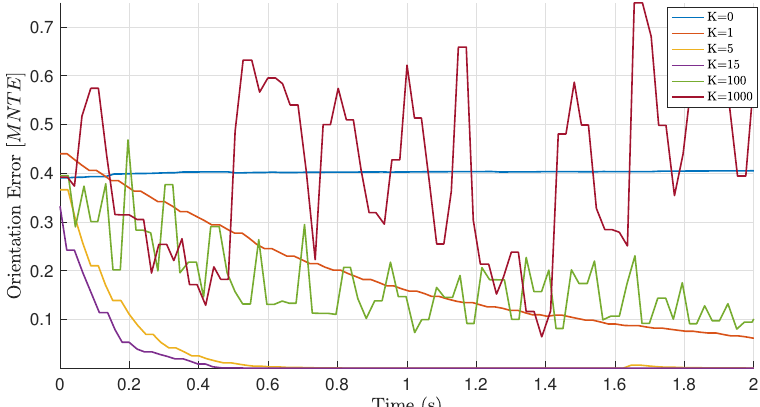
Figure 8. Convergence of the dynamical inverse kinematics optimization for static T-pose using a 66 degrees of freedom (DoF) model, starting from zero configuration. Convergence rate depends on the magnitude of the gain K